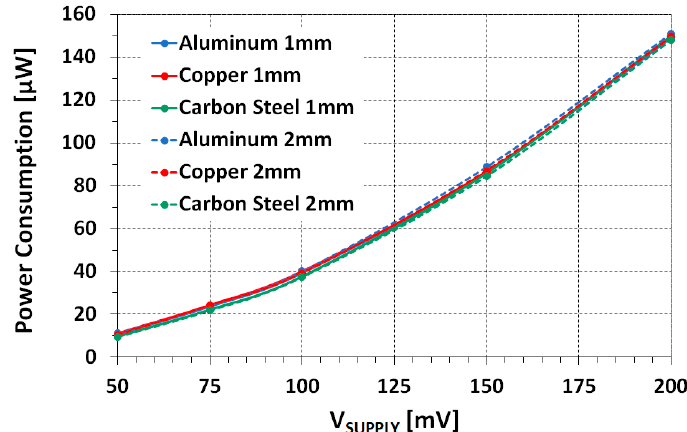
Figure 9. Power consumption of the realized Ultra-Low Power Eddy Current Sensor (ULP-ECDS) in the case of interactions with the three considered 1 mm thick targets (solid lines) and the three considered 2 mm thick targets (dashed lines), respectively. The measurements show that the power consumption depends only on V SUPPLY and not on the target.